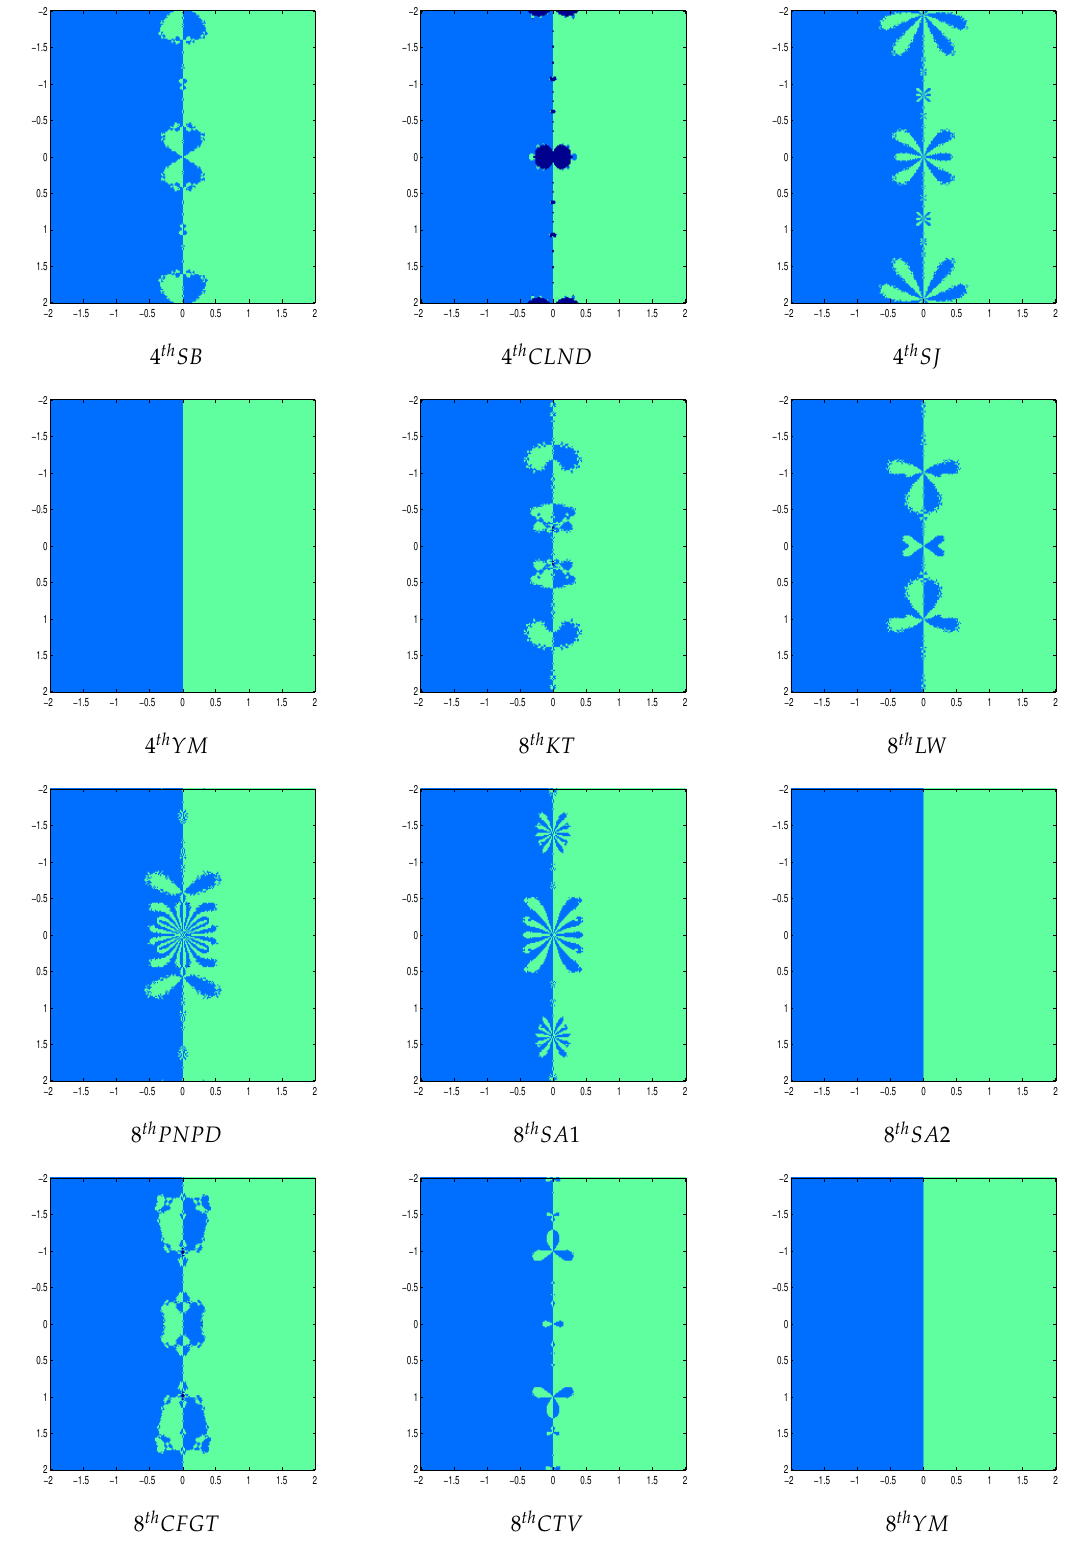
Figure 3. Basins of attraction for p 1 ( z ) = z 2 −